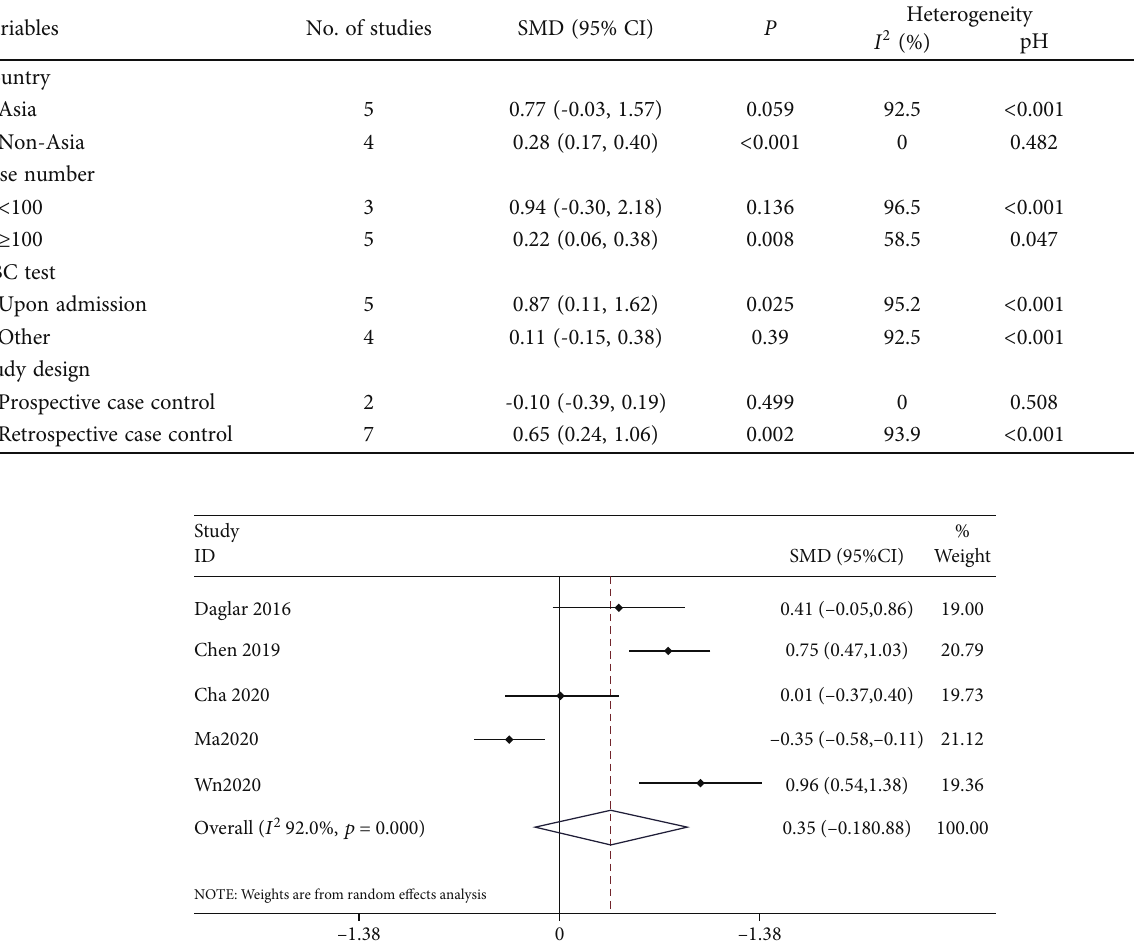
plete blood counts were tested at admission ( SMD = 0 : 87 ,